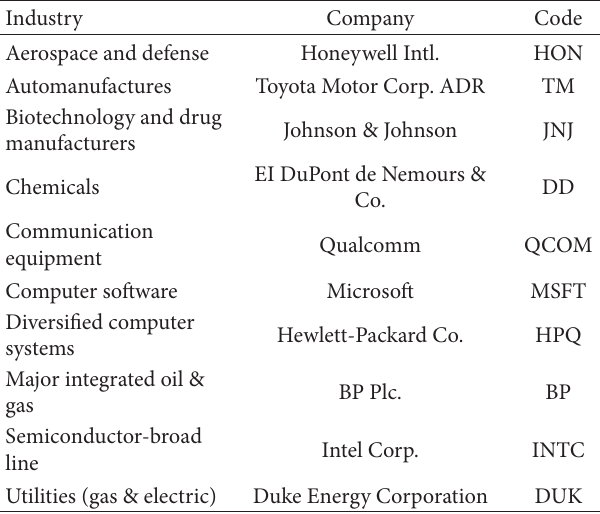
Table 2: Stocks in an incomplete market.